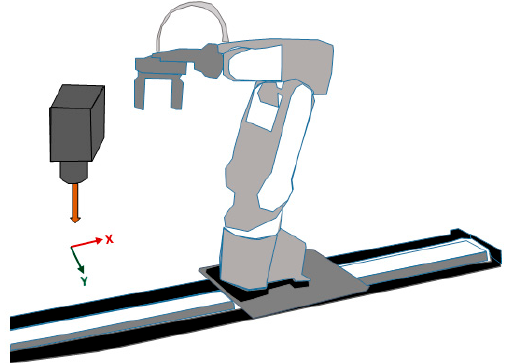
Figure 21. 2D visual tracking for a pick-and-place task.